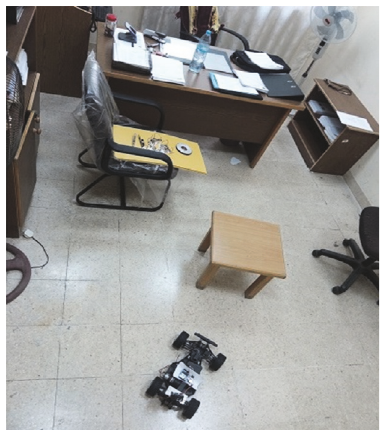
Figure 17: The histogram without equalization.